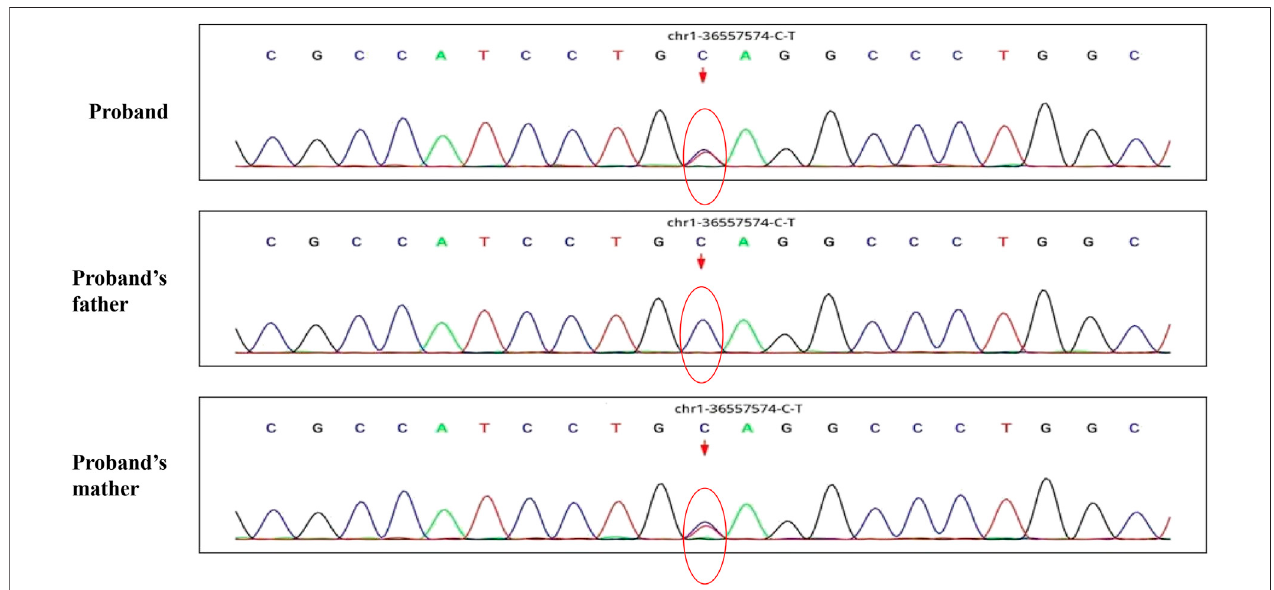
FIGURE 1 | The whole exon sequence of C.580C > T in this child patient and his parents.